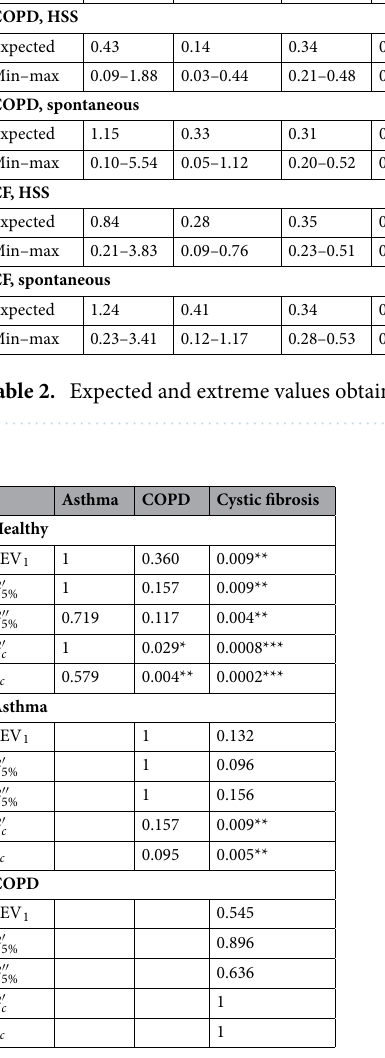
Table 3. Results of the ANOVA: p -values obtained from Bonferroni’s all pair comparison test. * p < 0.05 ; ** p < 0.01 ; *** p < 0.001